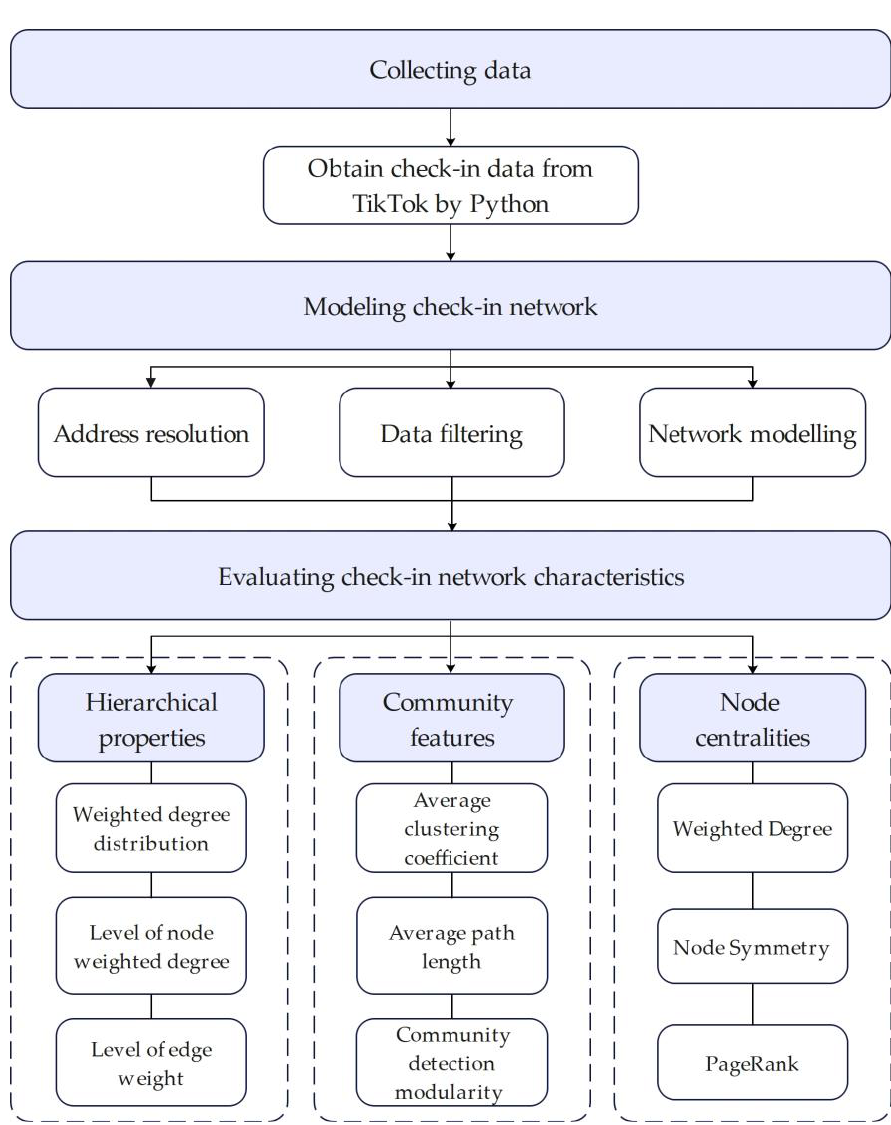
Figure 3. The technical route diagram.